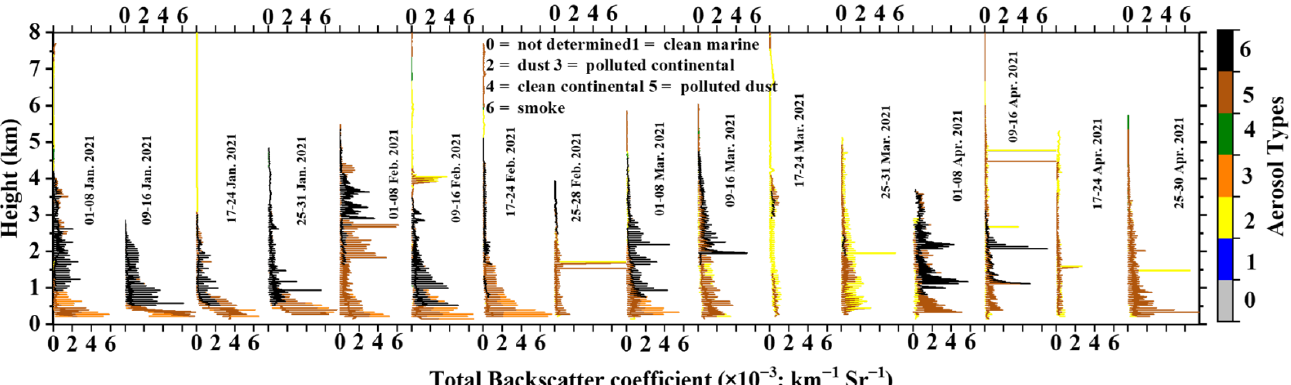
Figure 4. Weekly mean vertical profiles of the total backscattering coefficient during January to April 2021. The color bars show the aerosol type.